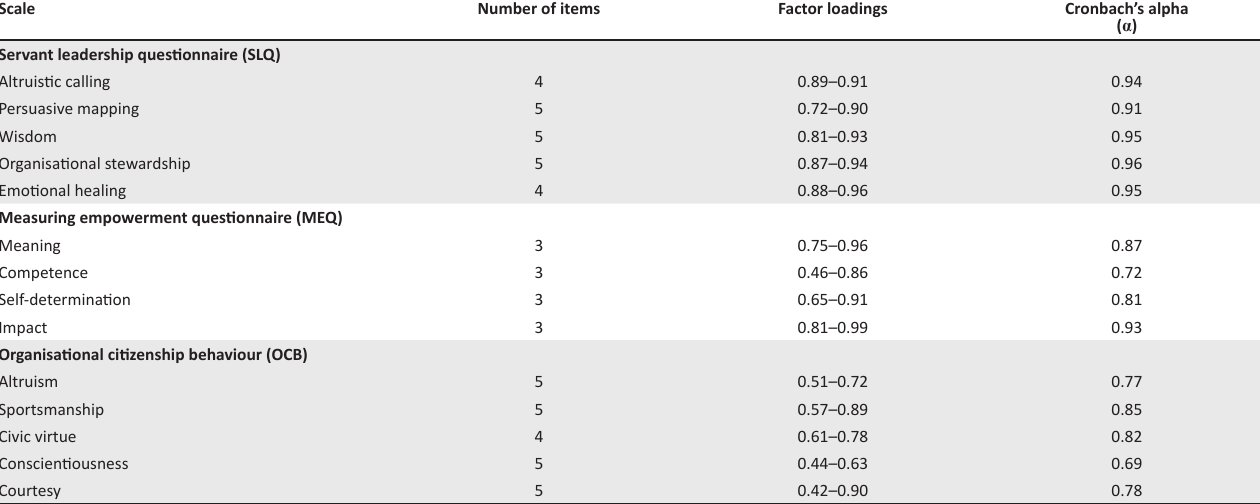
TABLE 3: Measurement scales: Factor loadings and reliability.